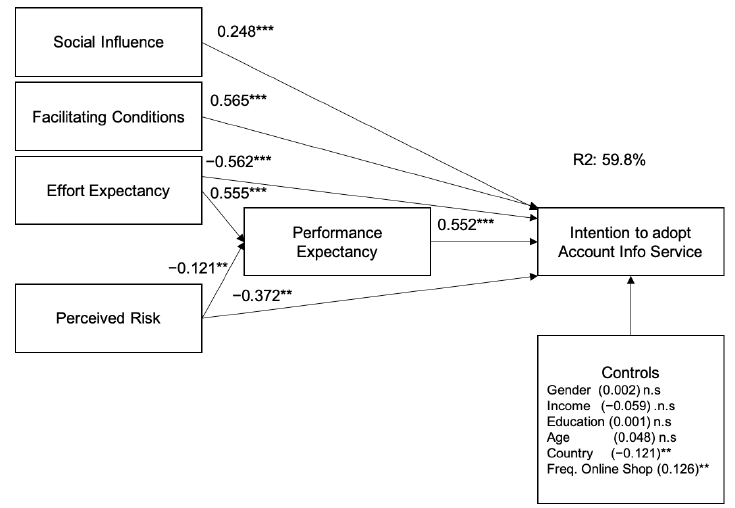
Figure 2. Structural model with path coefficients and